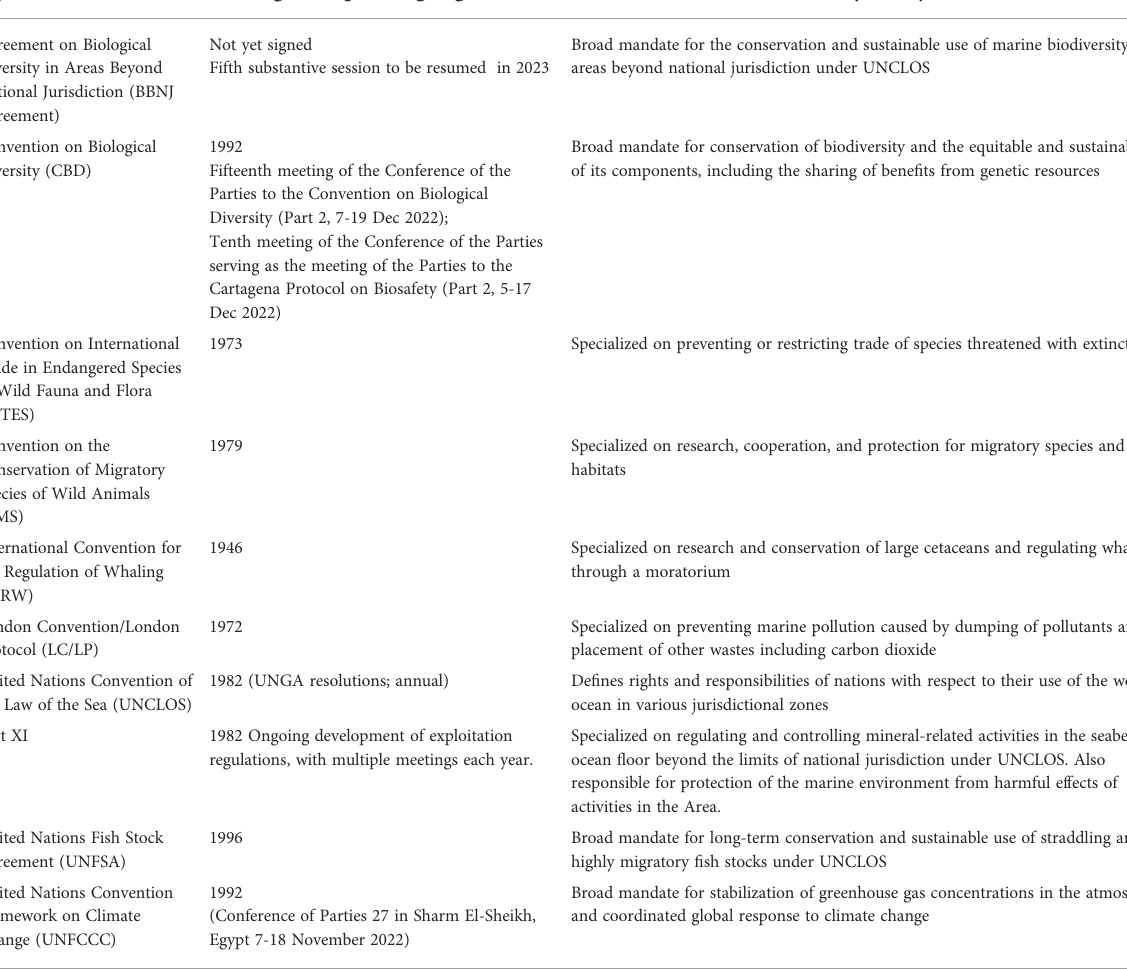
TABLE 1 The ten agreements include international legally binding and non-binding agreements at the intersection of ocean, biodiversity, and climate governance.